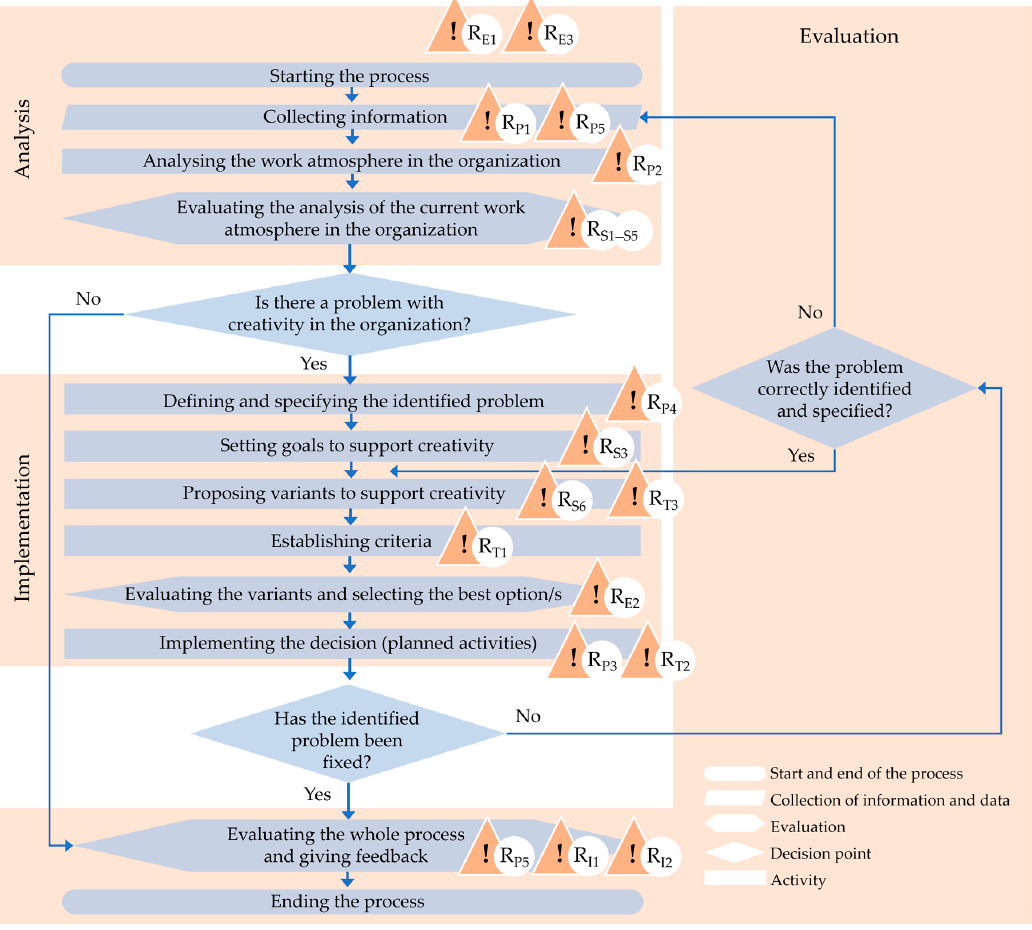
Figure 3. The process of direct creativity support (own